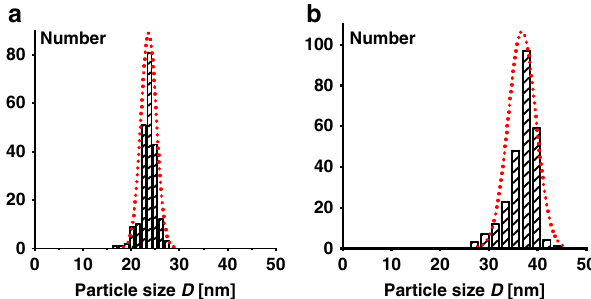
Fig. 7 Histograms of particle sizes (equivalent diameter D ) based on TEM statistics from obtained polyethylene dispersions. a After 30 min reaction time (entry 1, Table 2); b after 4 h reaction time (entry 4, Table 2). The dotted lines are calculated normal distribution